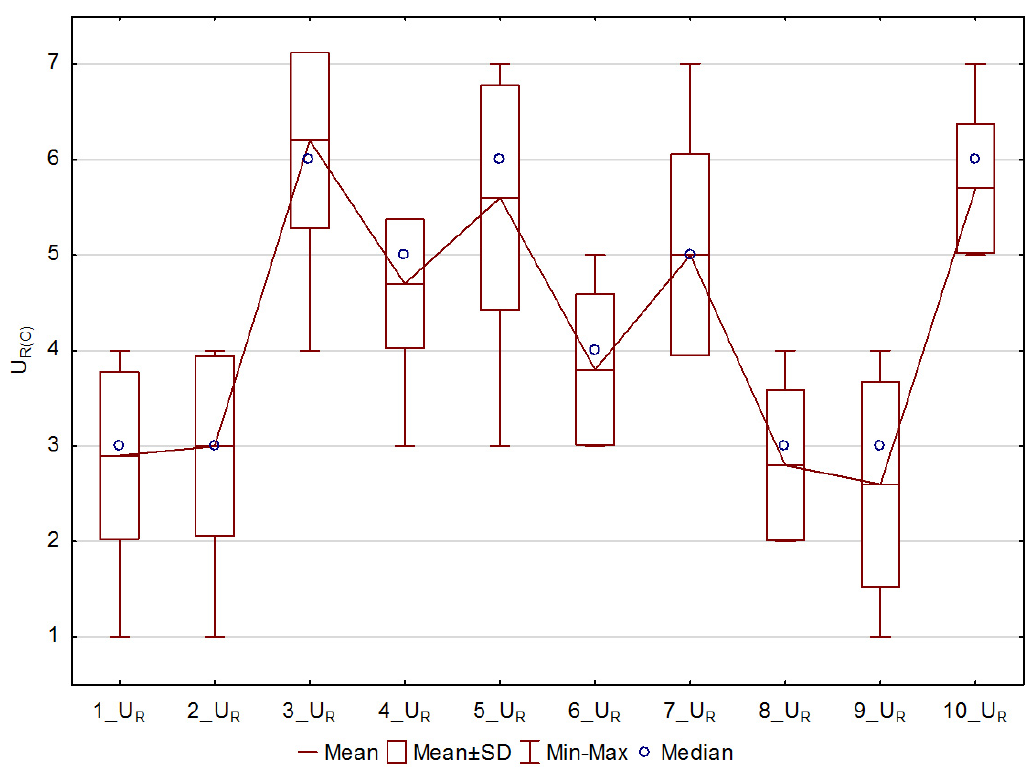
Figure 30. Corridor uniformity perception for group C.